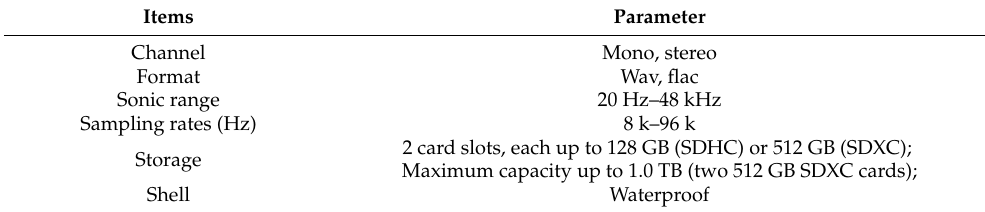
Figure 2. Deployment of sound recording sensors in sampling site and ambient environment status. ( a ) Sound recording sensor was deployed on the trunk 1.5 m above ground; ( b ) ambient environment of sampling site. Table 1. Technical parameters of the acoustic